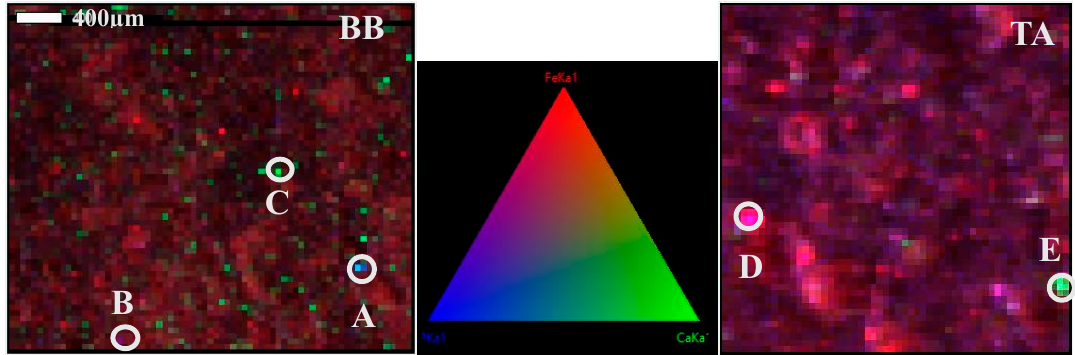
Figure 6. Elemental mapping for P (blue), Ca (green) and Fe (red) of BB and TA sediments with selected spots.